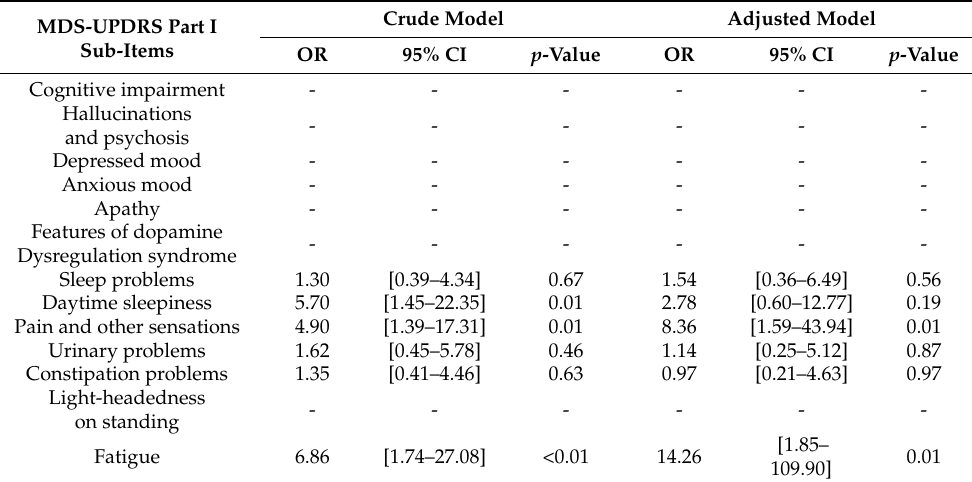
OR, odds ratio; 95% CI, 95% confidence interval of odds ratio; The adjusted model statistically controlled for age, gender, and mHY stage.